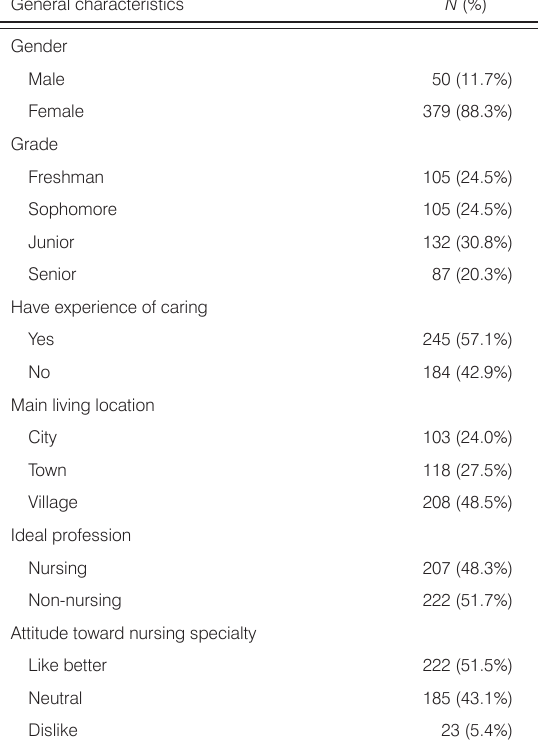
Table 1. Demographic characteristics of nursing students ( N =429) Table 2. Comparison of the mean and SDs of variables ( N